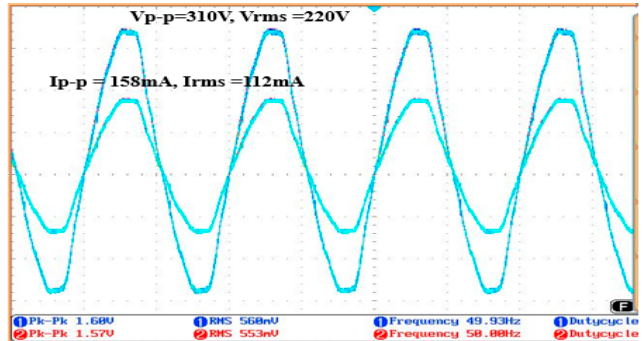
Figure 11. The measured input voltage: 220 V rms (50 V/division); the input current: 112 mA rms (7 mA/division). THD = 4.37% and P.F = 0.96.